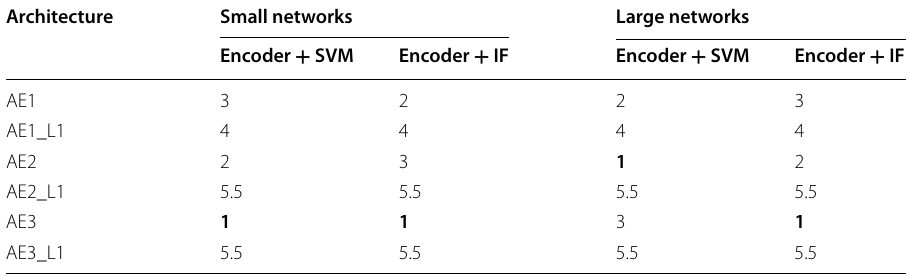
Table 8 Average ranks for autoencoder architectures when used as deep embeddings wit one-class SVM (on must-link constraints) and for Isolation Forest (on cannot-link